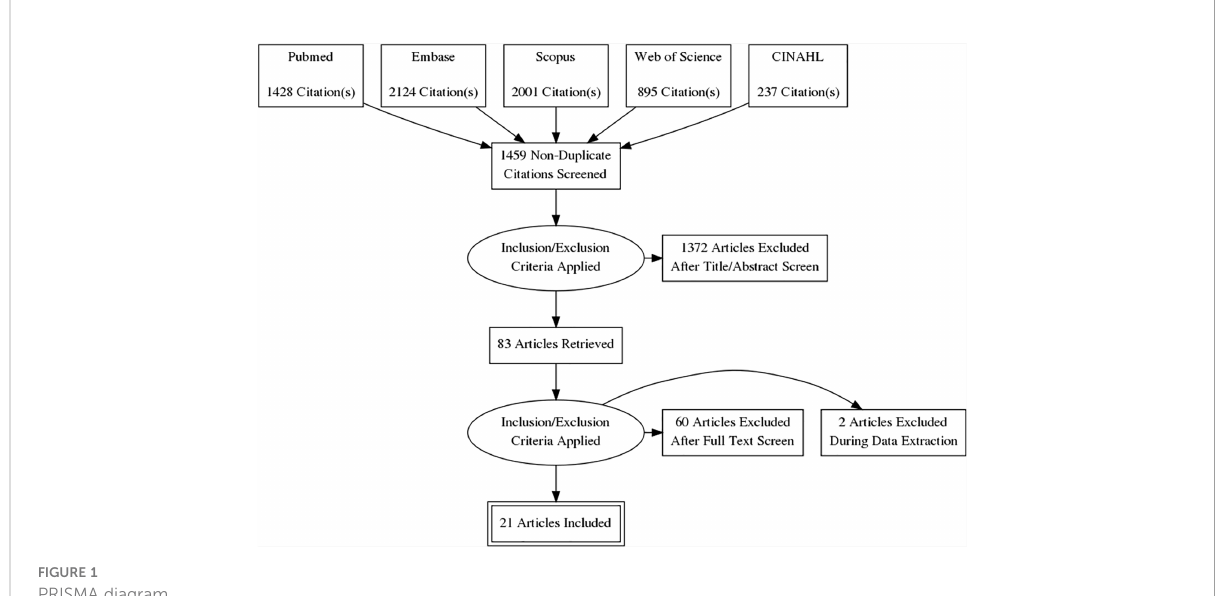
FIGURE 1 PRISMA